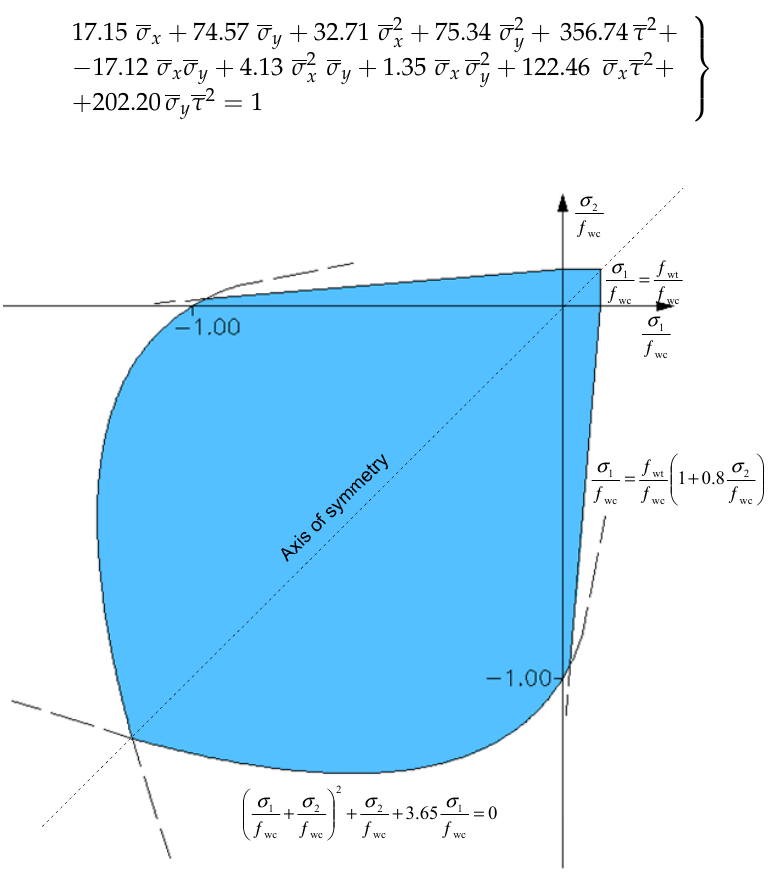
Figure 7. Kupfer and Gerstle isotropic failure criterion.